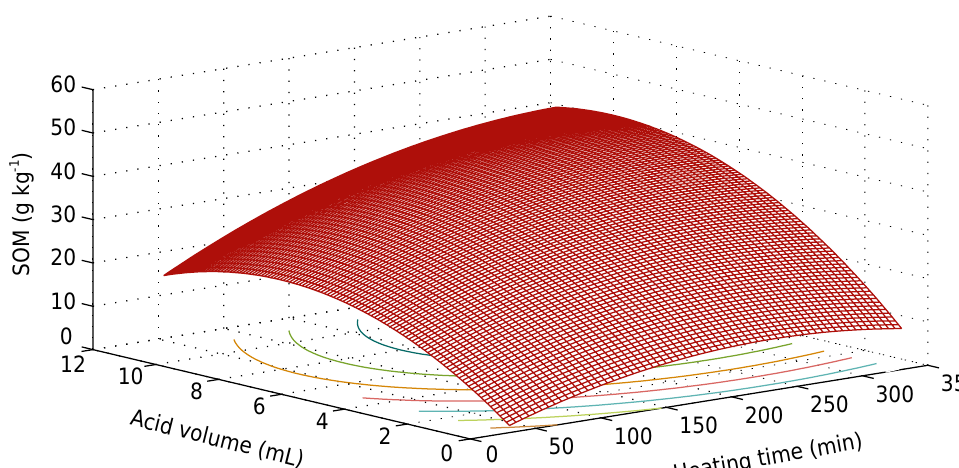
Figure 2. Response surface for soil organic matter (SOM) recovery due to independent variables: volume of concentrated sulfuric acid and heating time at 140